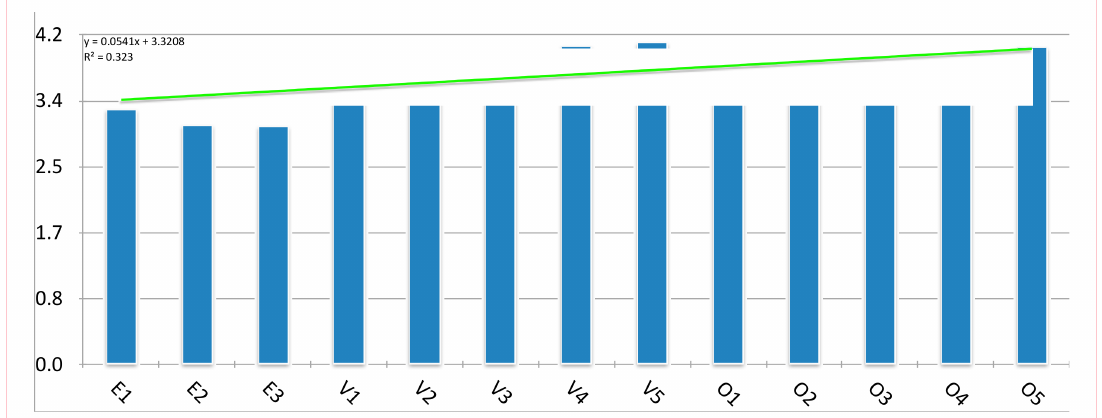
Figure 4. Assessment of the platform created based on the students’ opinion